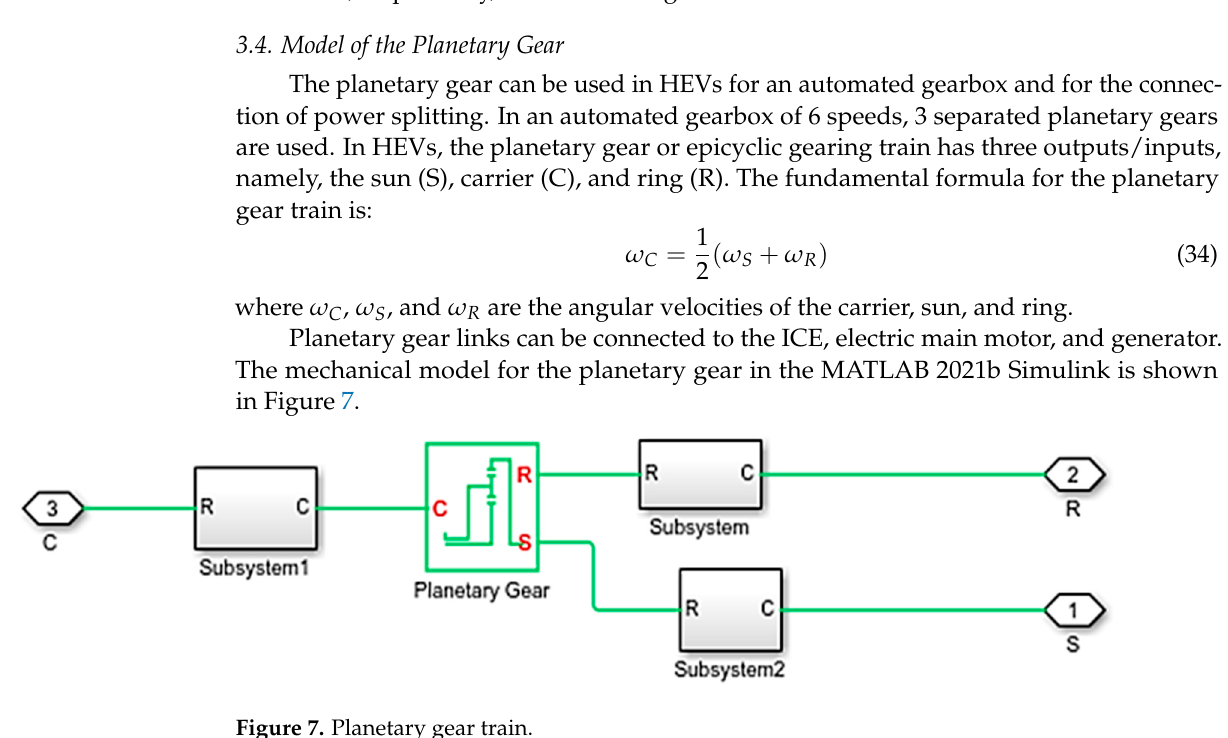
Figure 7. Planetary gear train .